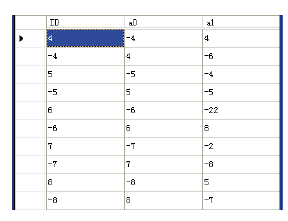
Figure 6. Line unit algebraic structure-railway